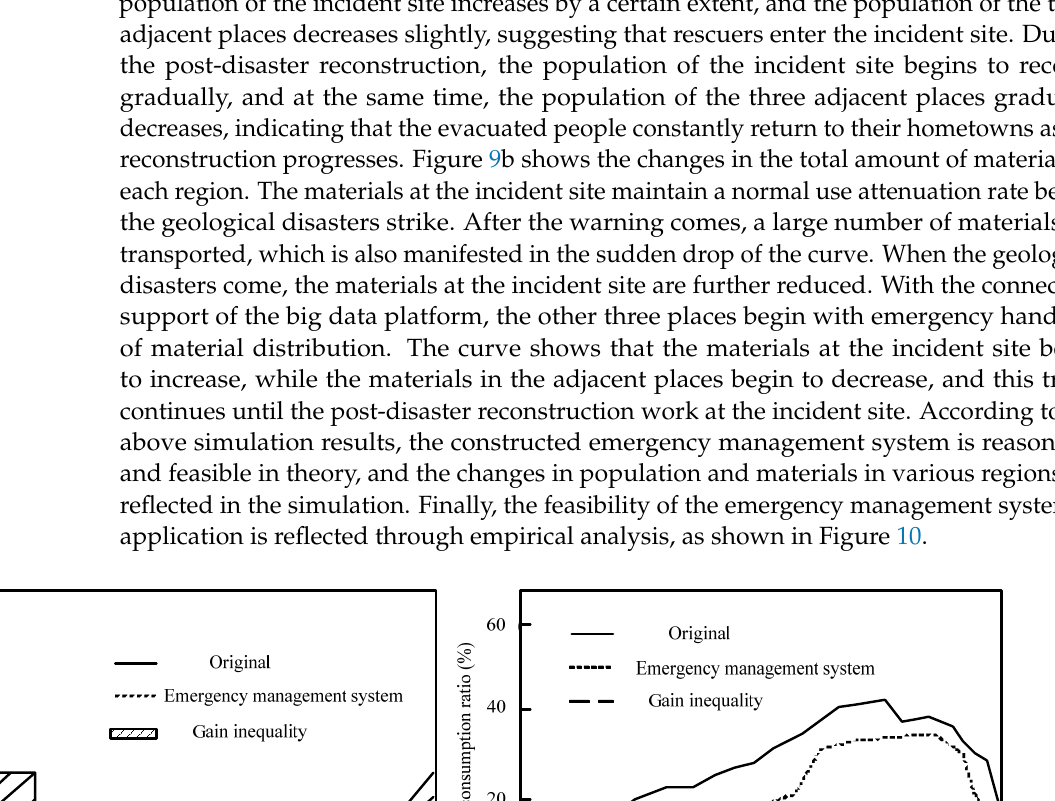
Figure 9. Simulation analysis of emergency management system.